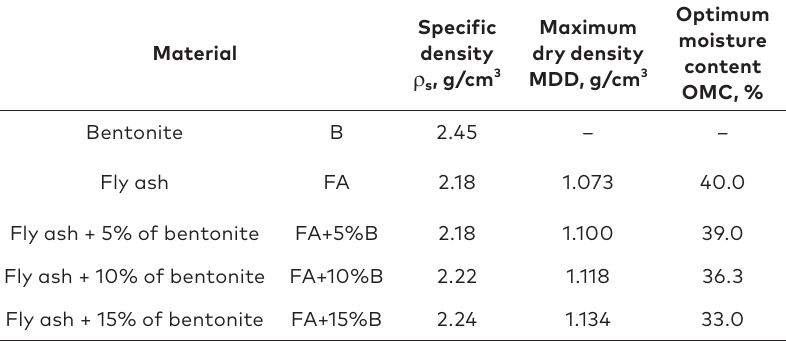
Table 2. Geotechnical properties of tested